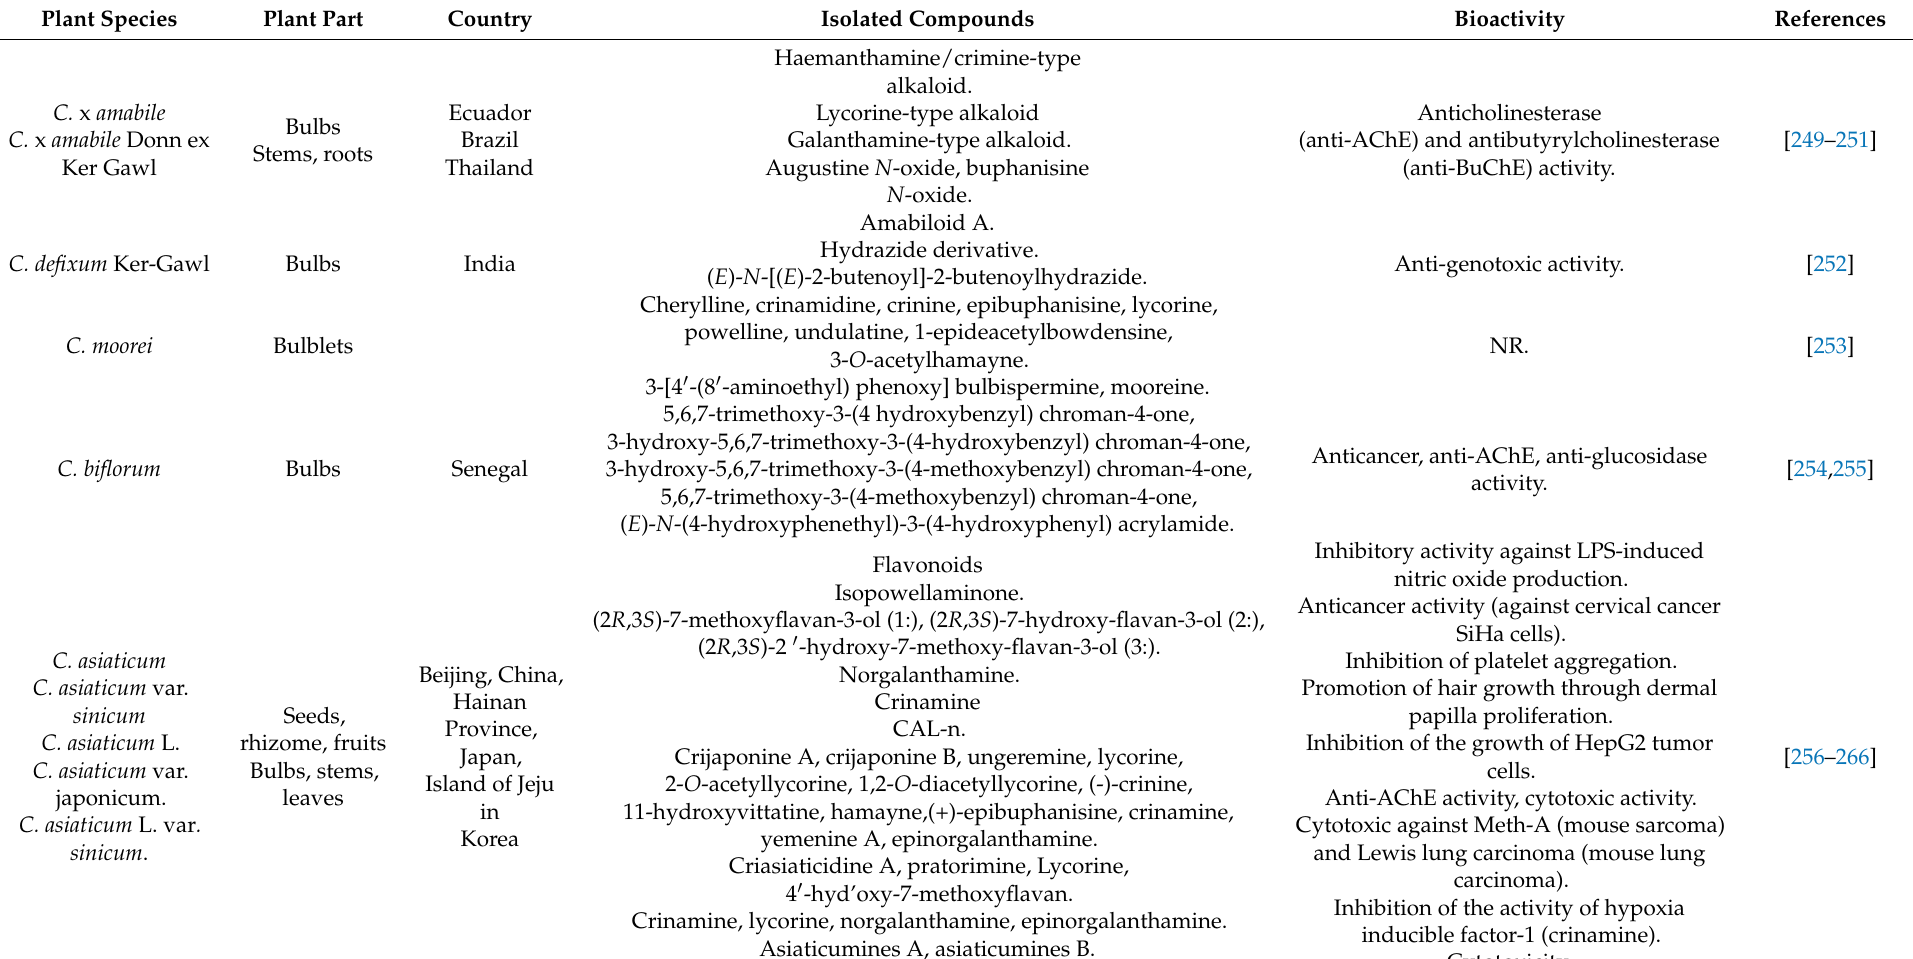
Table 11. Bioactive compounds isolated from Crinum